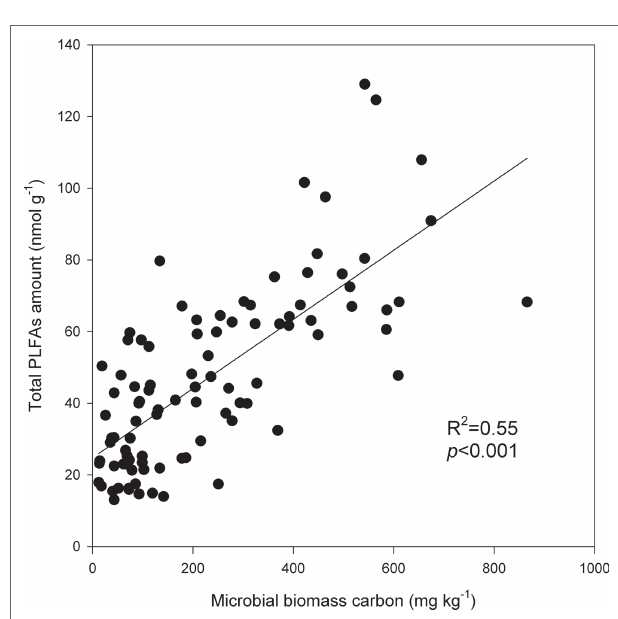
FIGURE 3 | Linear relationship between the total amounts of phospholipid fatty acids (PLFAs) and soil microbial biomass carbon. The plots are observation values, and the solid line is the linear regression line. The coefficient of determination R 2 and significance level p are